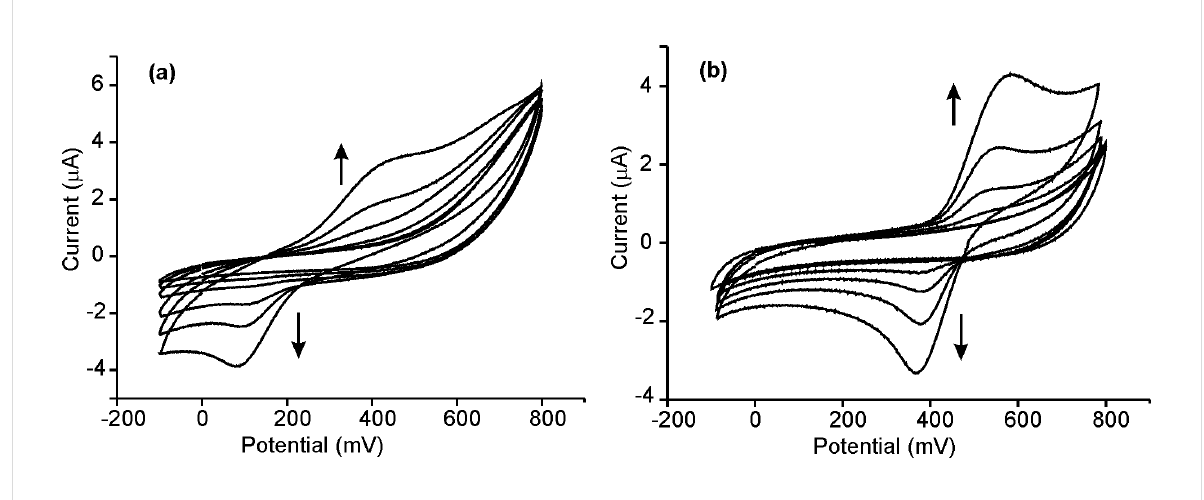
Figure 5: Voltammograms registered using electrodes deposited by CP on SS immersed in 1·10 − 5 to 1·10 − 3 mol/L solutions of catechol in 0.01 mol/L phosphate buffer (pH 7.0): (a) Ppy-CP SS (b) Ppy/AuNP-T-CP SS .